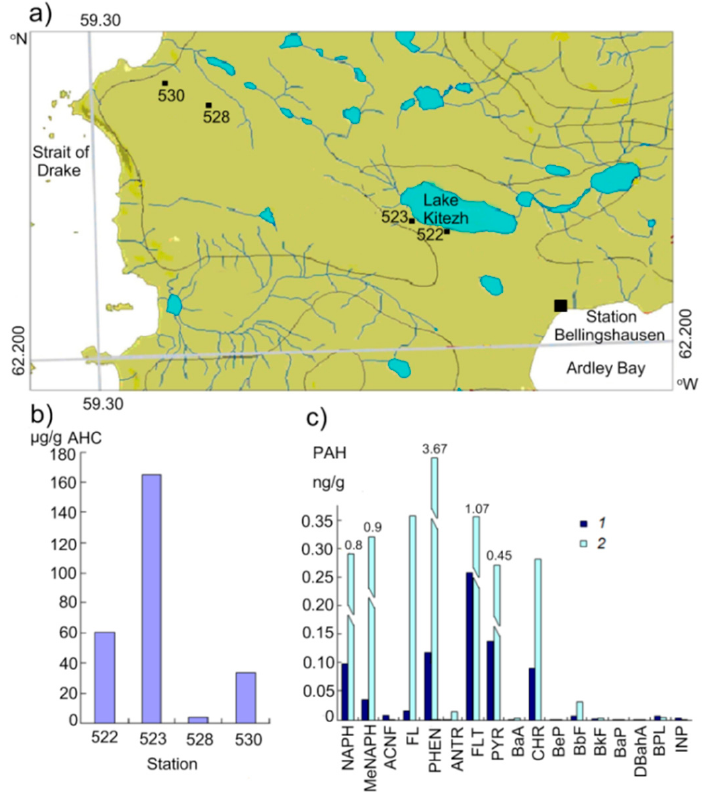
Figure 15. Sampling scheme in the vicinity of Bellingshausen Station, 2012 ( a ), composition AHCs in moss ( b ) and composition of polycyclic aromatic hydrocarbons in moss ( c ).